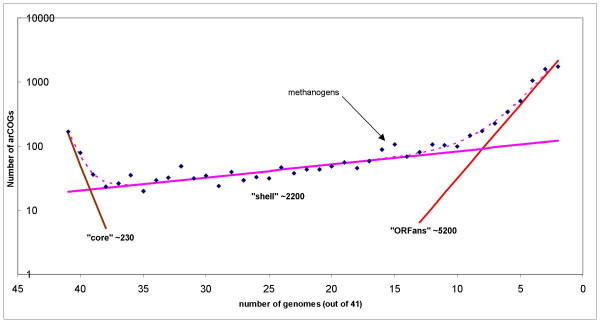
Distribution of the number of species in arCOGs: three classes of archaeal genes. A semi-logarithmic plot fitted with a sum of 3 exponents